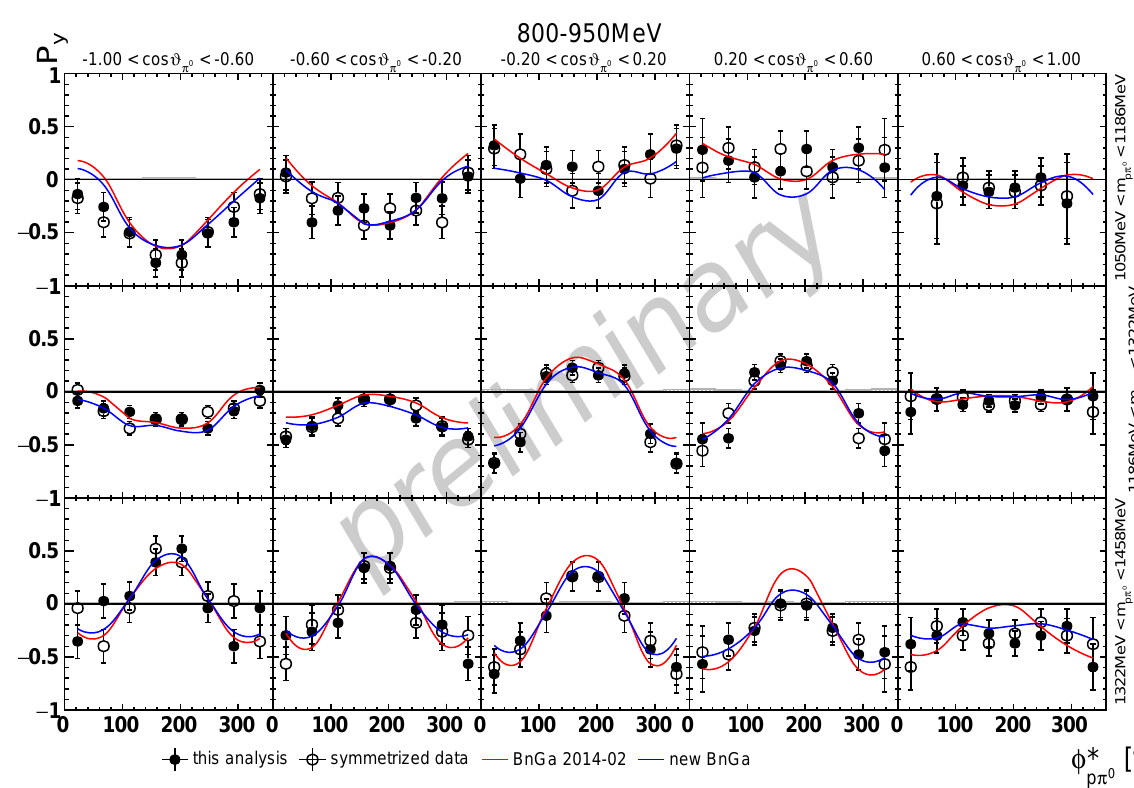
Figure 6. Targetasymmetry P y as a function of φ ∗ in the energy bin (800 – 950)MeV. Within a row the cos ϑ π 0 is varied, within a p π 0 column the invariant mass m . Only a single energy bin is shown here. p π 0